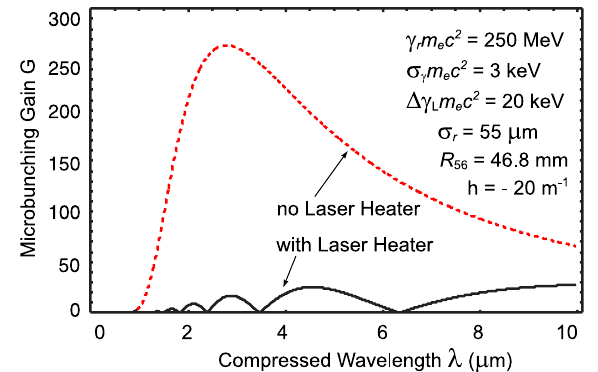
FIG. 15. Microbunching gain vs wavelength after compression with and without taking into account the effect of the laser